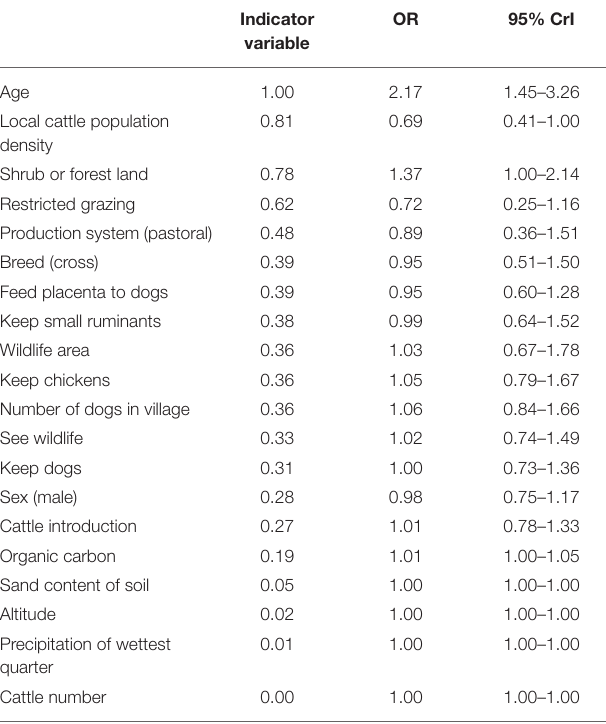
TABLE 3 | Risk factors to Neospora caninum in cattle in northern Tanzania selected using Bayesian model averaging. Indicator